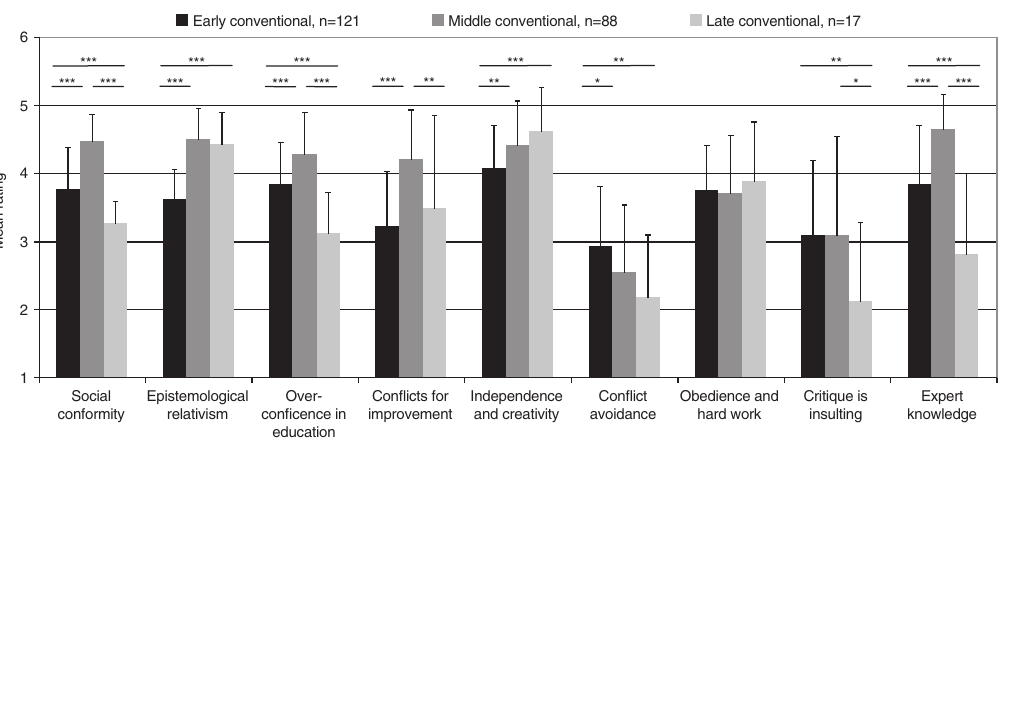
Figure 2. Characteristics of the early, middle and late con v entional v alue systems expressed as mean rating and SD of the 9 variables identified by the factor analysis. Statistical comparisons by Benferroni adjusted post-hoc tests and le v el of significance indicated by stars (* p B 0.05, ** p B 0.01, *** p B